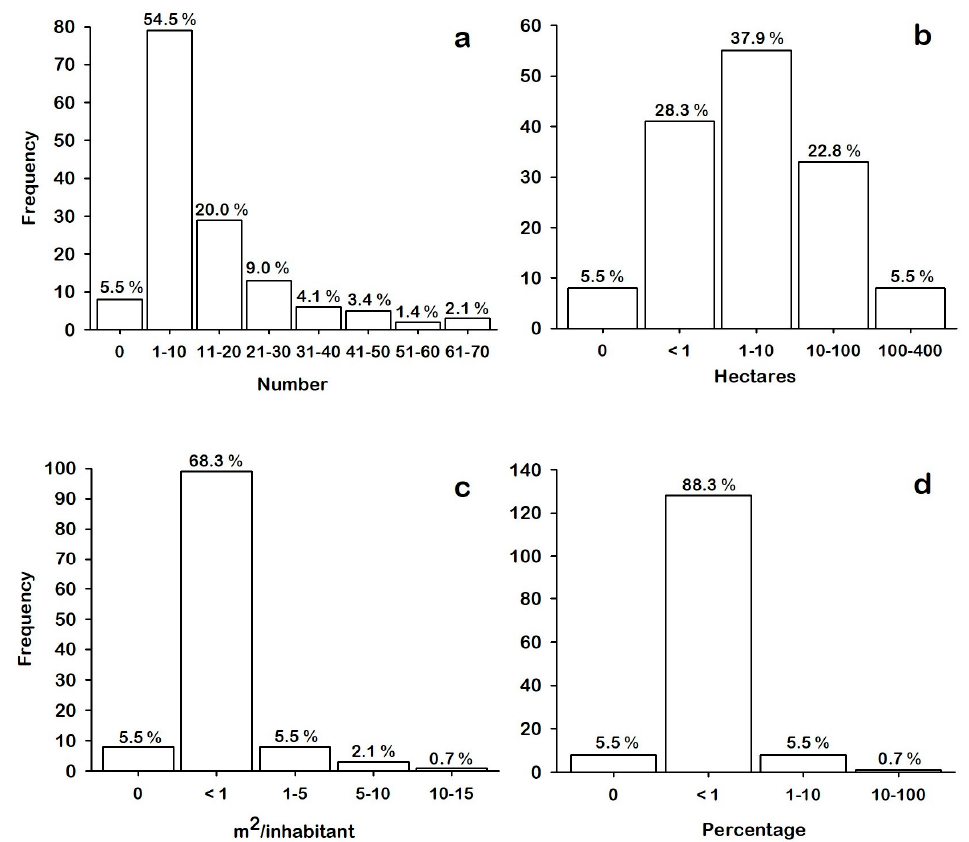
Figure 4. Total frequencies for the four estimated indices from lacustrine blue spaces in cities. ( a ) Number of blue spaces, ( b ) surface of blue spaces in hectares, ( c ) surface of blue spaces per inhabitant in m 2 , and ( d ) percentage that blue spaces cover of the city area.